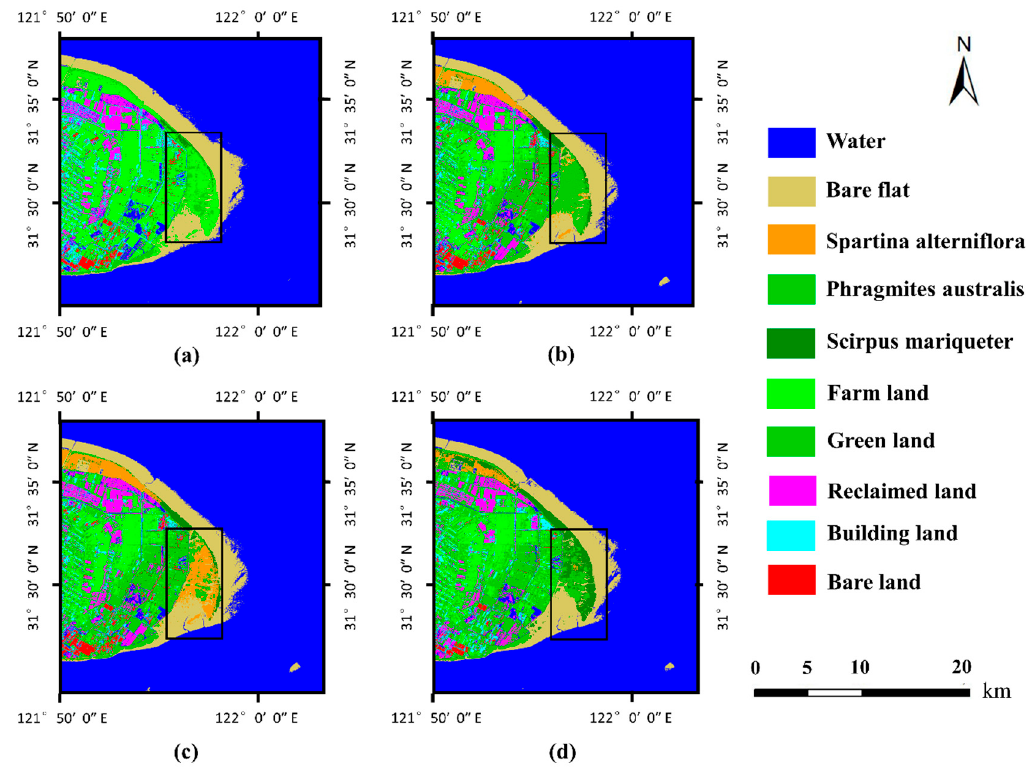
Figure 3. Classification results in 2009 of the four methods: ( a ) maximum likelihood classification (MLC); ( b ) extreme learning machine (ELM); ( c ) support vector machine (SVM); and ( d ) kernel extreme learning machine (K-ELM).